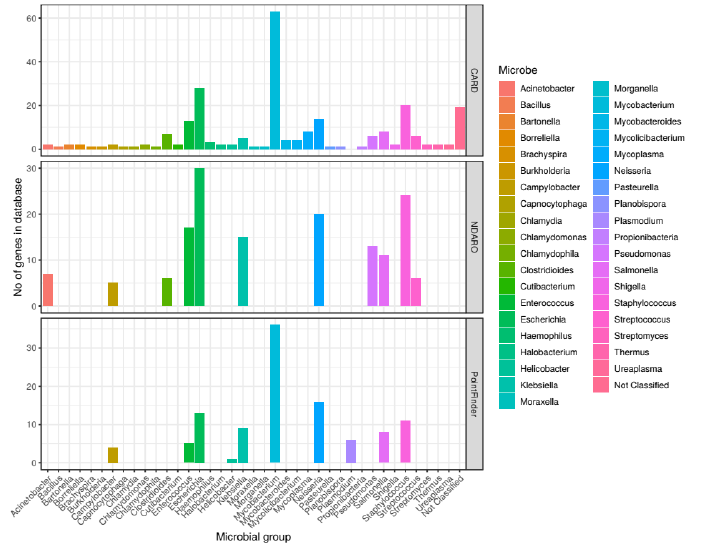
Figure 3. Number of genes conferring resistance through mutations for each microbial genus in CARD, NDARO and MEGARes databases. Genes conferring resistance through mutations was calculated at the genus level for each microbe stored in each database. Only one group could not be summarized at the genus level (propionibacteria). Microbial genus is on the x axis and the number of genes associated with each group in the database is represented by the y axis. Rows show the data separately for each database. Columns are colored by the microbial genus.